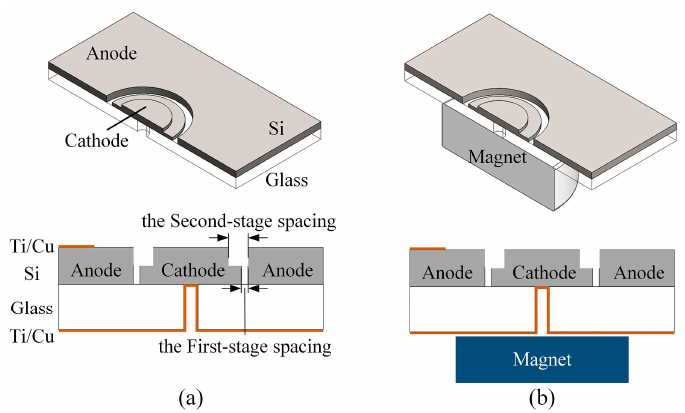
Figure 1. The schematic diagram of ion source structure: ( a ) without-magnet configuration; ( b ) with-magnet configuration.